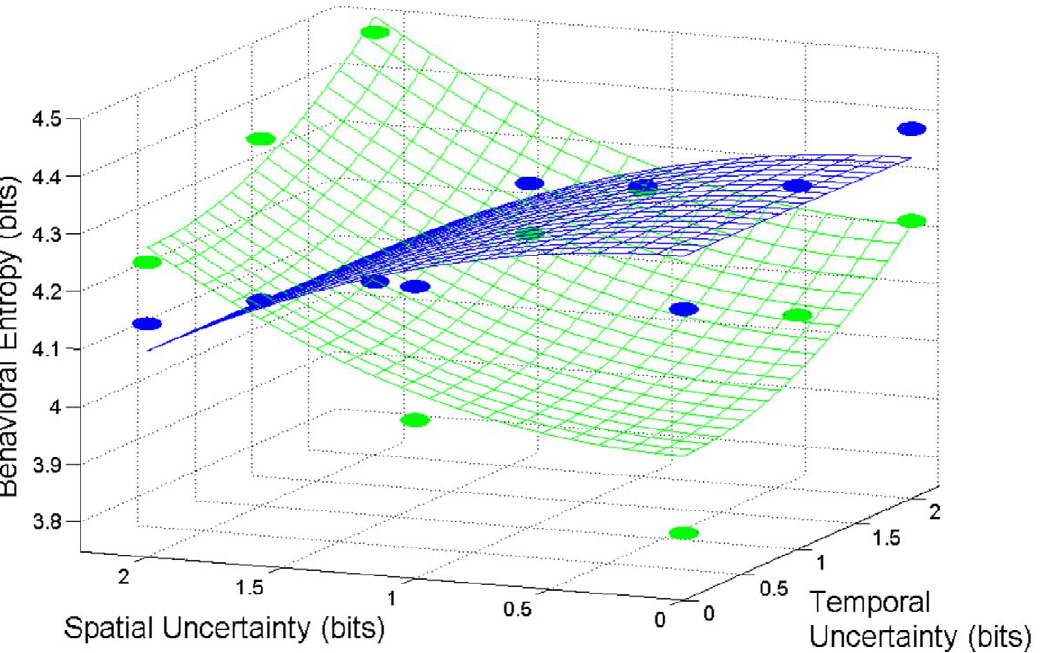
Figure 5. Combined quadratic surfaces for RT and fixation duration. The surfaces represent both cognitive and motor entropy as a function of spatial and temporal uncertainty of the visual stimulus. The blue surface and data points represent the eye fixation duration entropy data while the green surface and data points represent the RT entropy data.